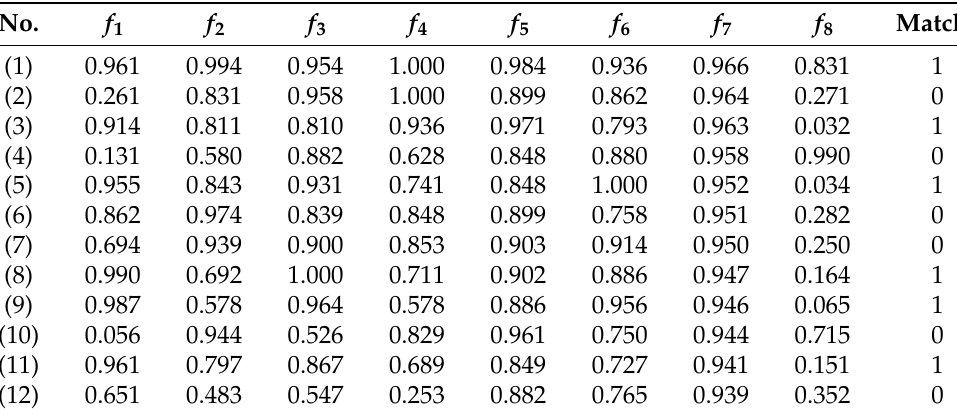
Table 1. Extracted sea wave features (part of train data).